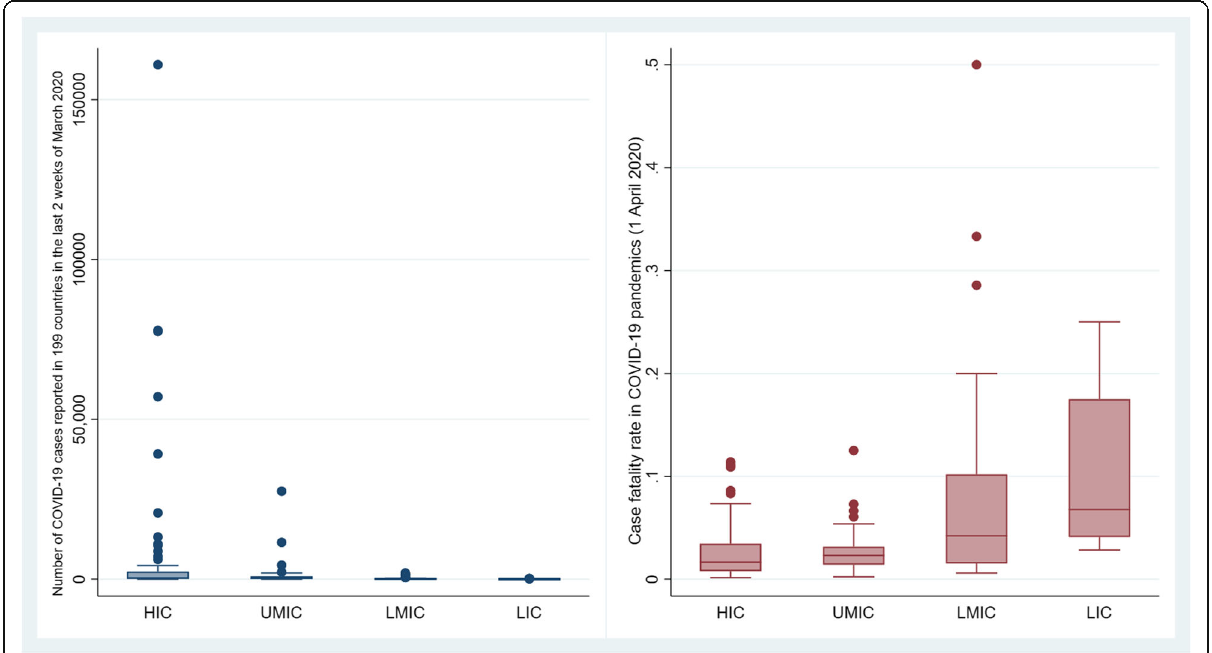
Fig. 1 New cases of COVID-19 (left) and death rate (right) observed globally in countries with different income status as of 1 April 2020. HIC, high-income countries; UMIC upper-middle-income countries; LMIC, lower-middle-income countries; LIC low-income